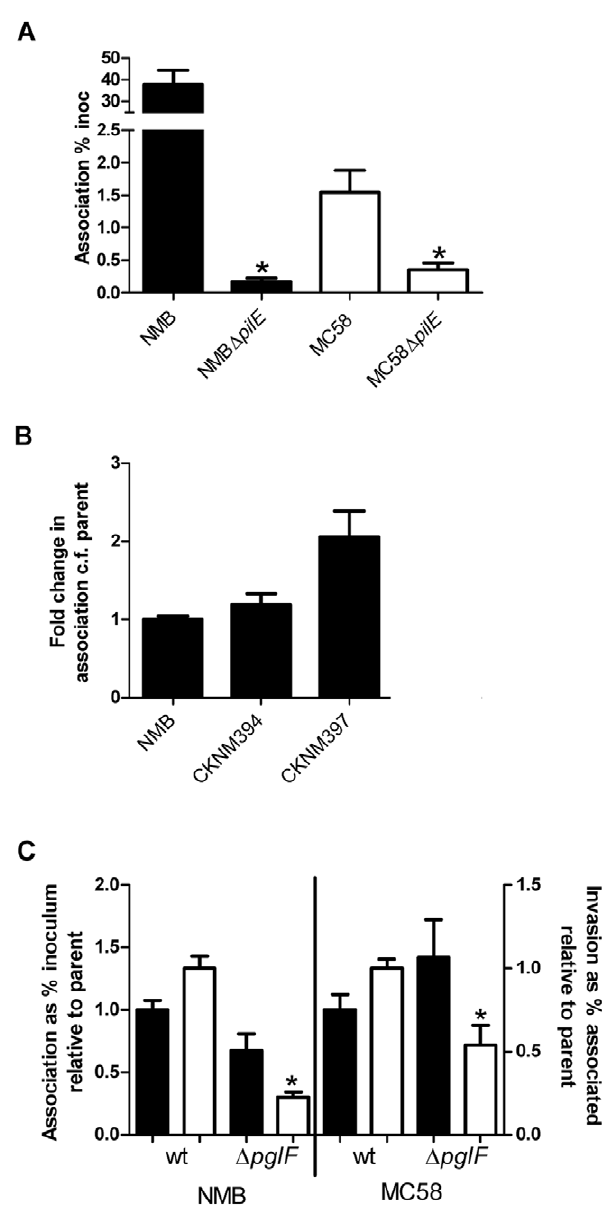
Figure 3. The role of Type IV pili is conserved in bacterial association with host cells. Panel A. The ability of strains lacking pili ( D pilE ) to attach to Detroit 562 cells was compared to the parental wild- type. Strains NMB-CDC and MC58 and their respective pilE mutant strains are shown in black and white, respectively. All strains were Opa + , Cap + and LNT + . The average rate ( + / 2 SEM) of association as a percentage of the inoculum of three biological repeats in triplicate as determined by viable counts following 6 hr co-incubation is shown. Panel B. The role of the class of pilin in association with host cells. Strain NMB-CDC was modified to express class I pilin from the iga locus in the absence of an intact pilEII locus (CKNM397). All strains were Opa + , Cap + and LNT + . The ability of CKNM397 to associate with Detroit 562 cells was compared to parental wild-type strain NMB-CDC and CKNM394 containing an inactivated iga locus. The rate of association as a percentage of the inoculum of three biological repeats in triplicate was determined by viable counts following 1 hr co-incubation. The relative rate of association of each strain was normalised to strain NMB-CDC (value of 1) and is plotted as the average fold change ( + / 2 SEM). *: p , 0.005 determined by Mann-Whitney t-test. Panel C. The expression of a pilin glycan containing either GATDH (strain NMB-CDC) or